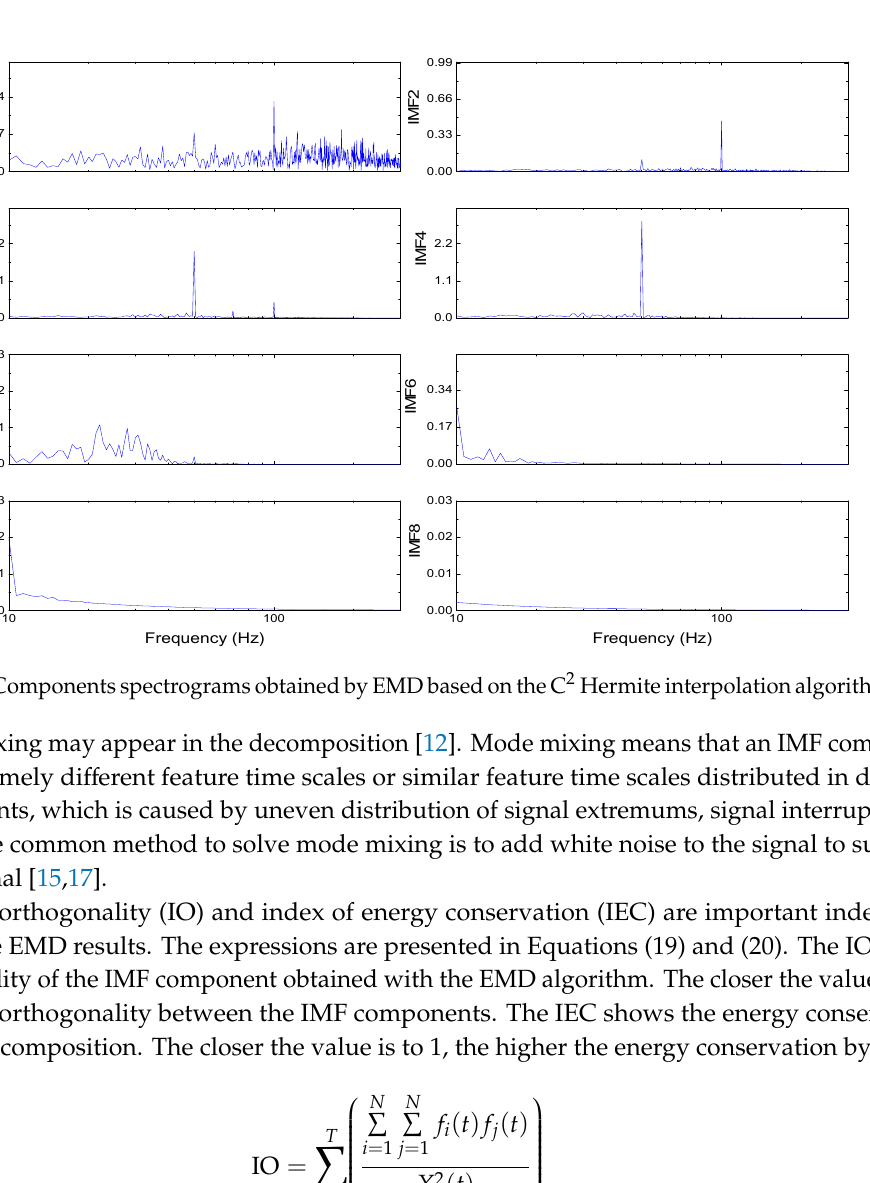
Figure 4. Intrinsic mode function (IMF) components obtained by the empirical mode decomposition (EMD) based on the C 2 Hermite interpolation algorithm.